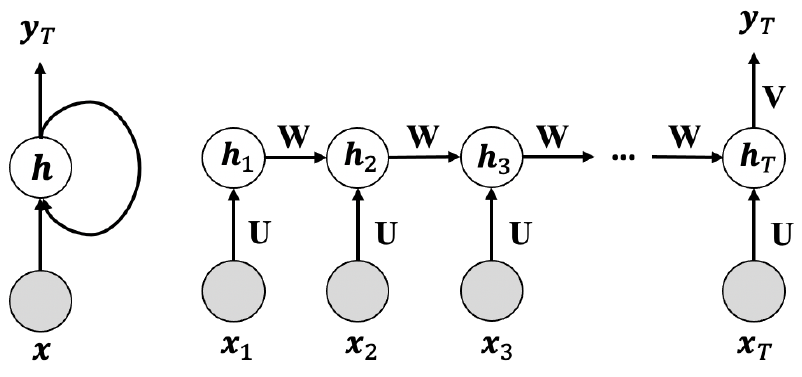
Figure 1. An example of the RNN